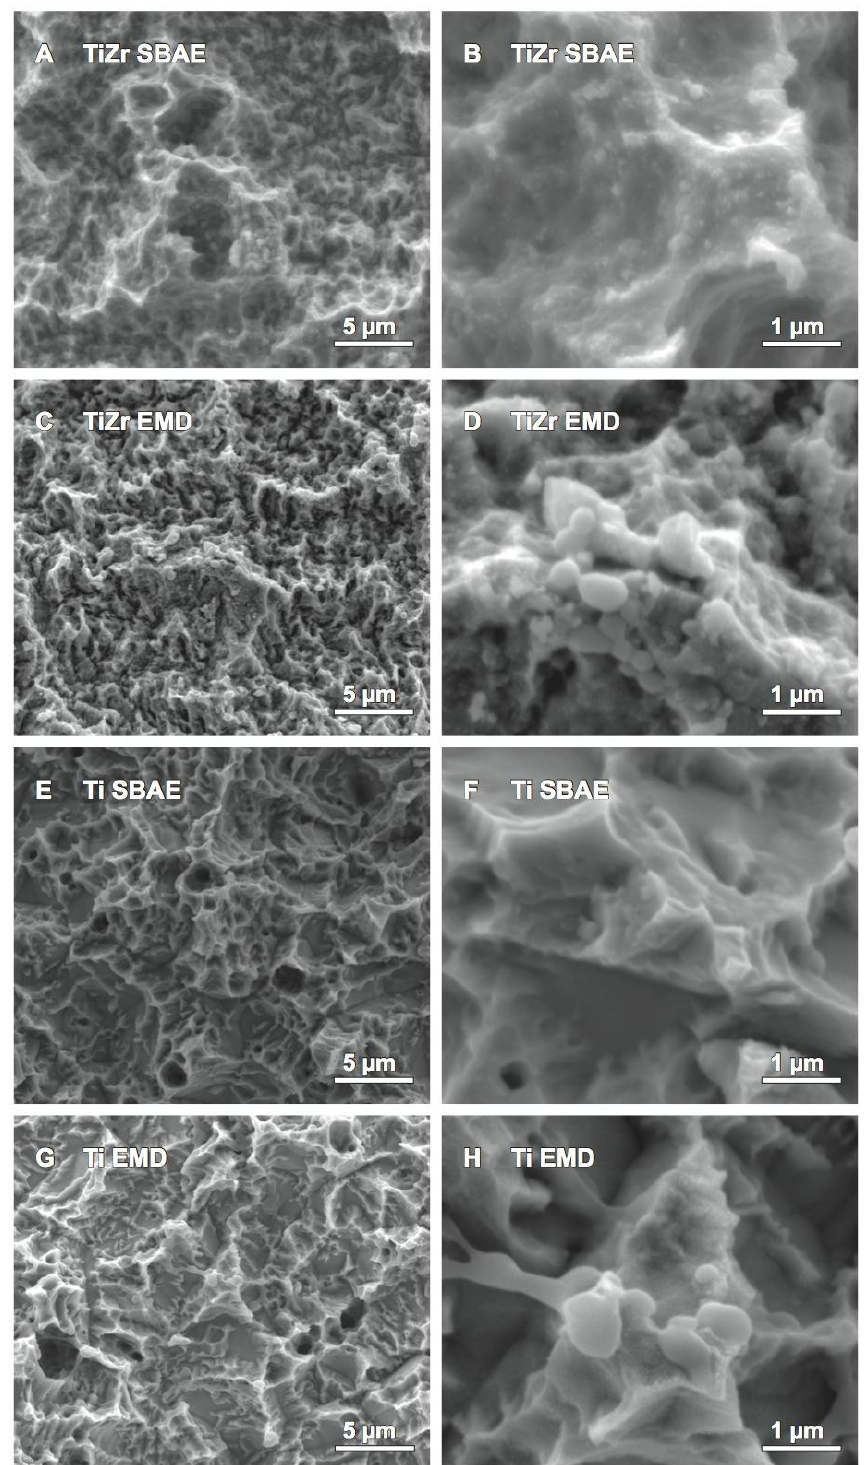
Figure 2. SEM images of ( A , B ) TiZr SBAE; ( C , D ) TiZr EMD; ( E , F ) Ti SBAE and ( G , H ) Ti